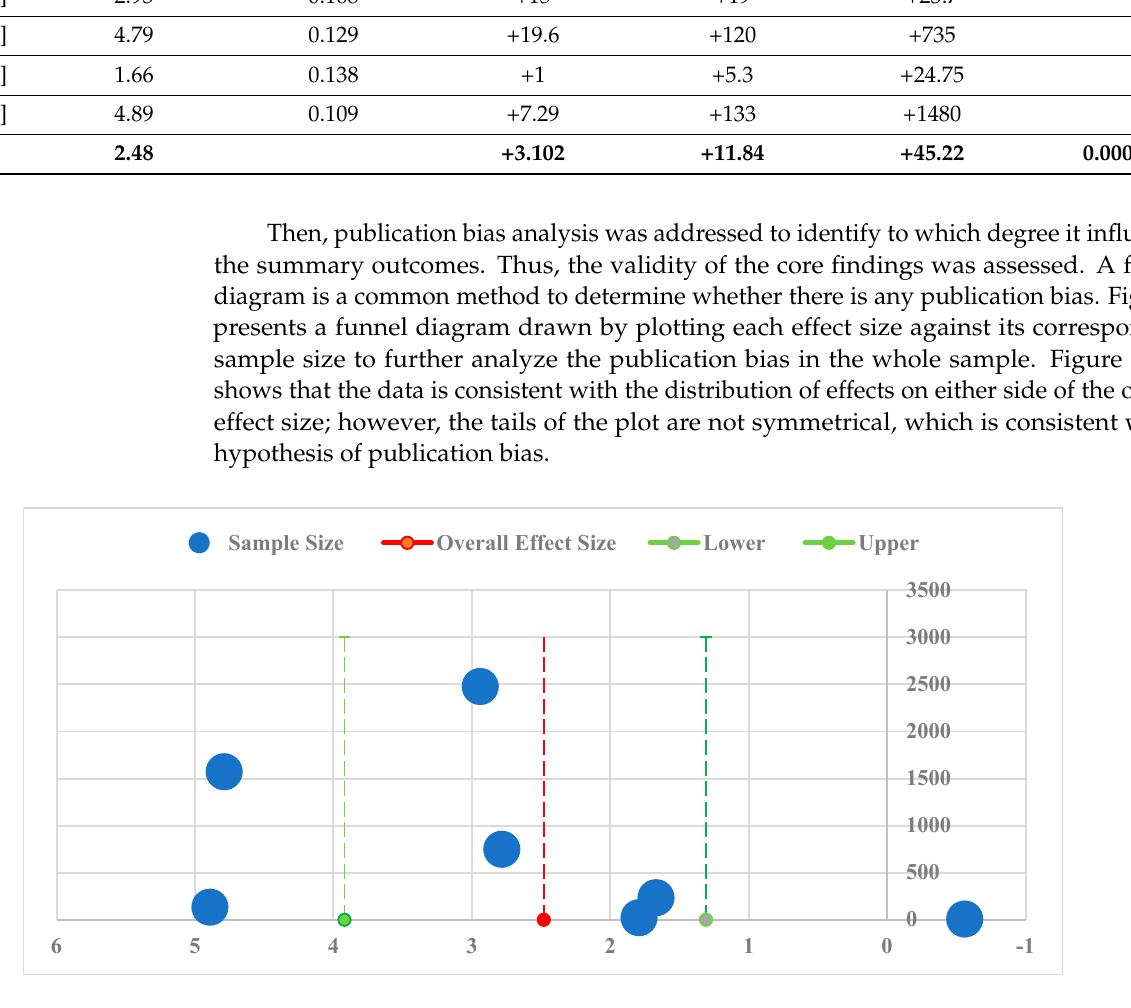
Table 7. Results from Random effect meta-analysis model.